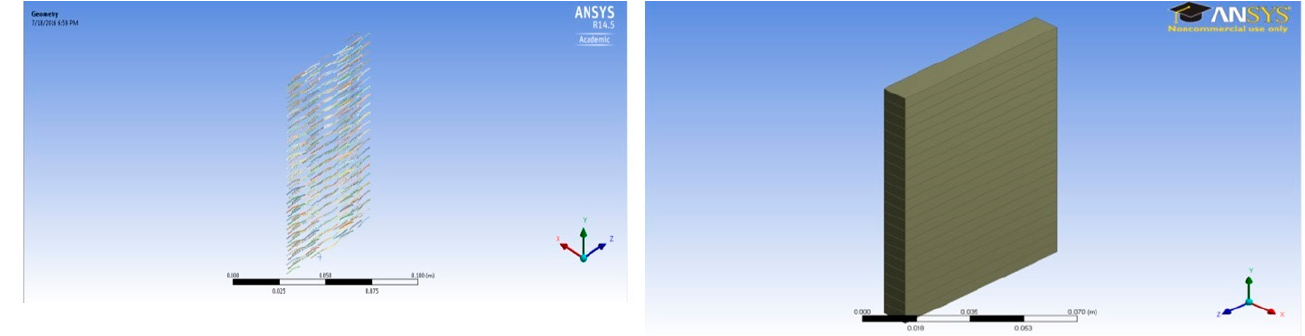
Figure 4. One percent fiber sample model (11 × 7 × 1 cm) and concrete slab.